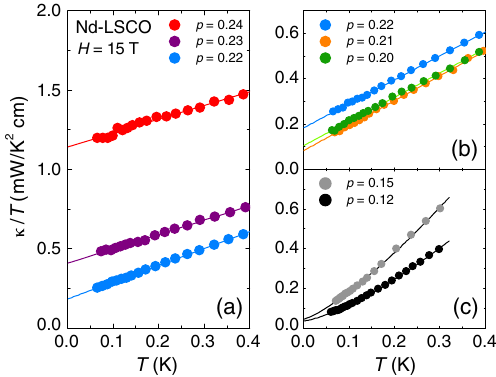
(c)(a) FIG. 3. κ =T vs temperature for Nd-LSCO at H ¼ 15 T, for (a) p ¼ 0 . 22 , 0.23, and 0.24, (b) p ¼ 0 . 20 , 0.21, and 0.22, and (c) p ¼ 0 . 12 and 0.15. In panels (a) and (b), the lines are linear fits to the data over the entire range shown. In panel (c), the lines are power-law fits to the data over the entire range of the